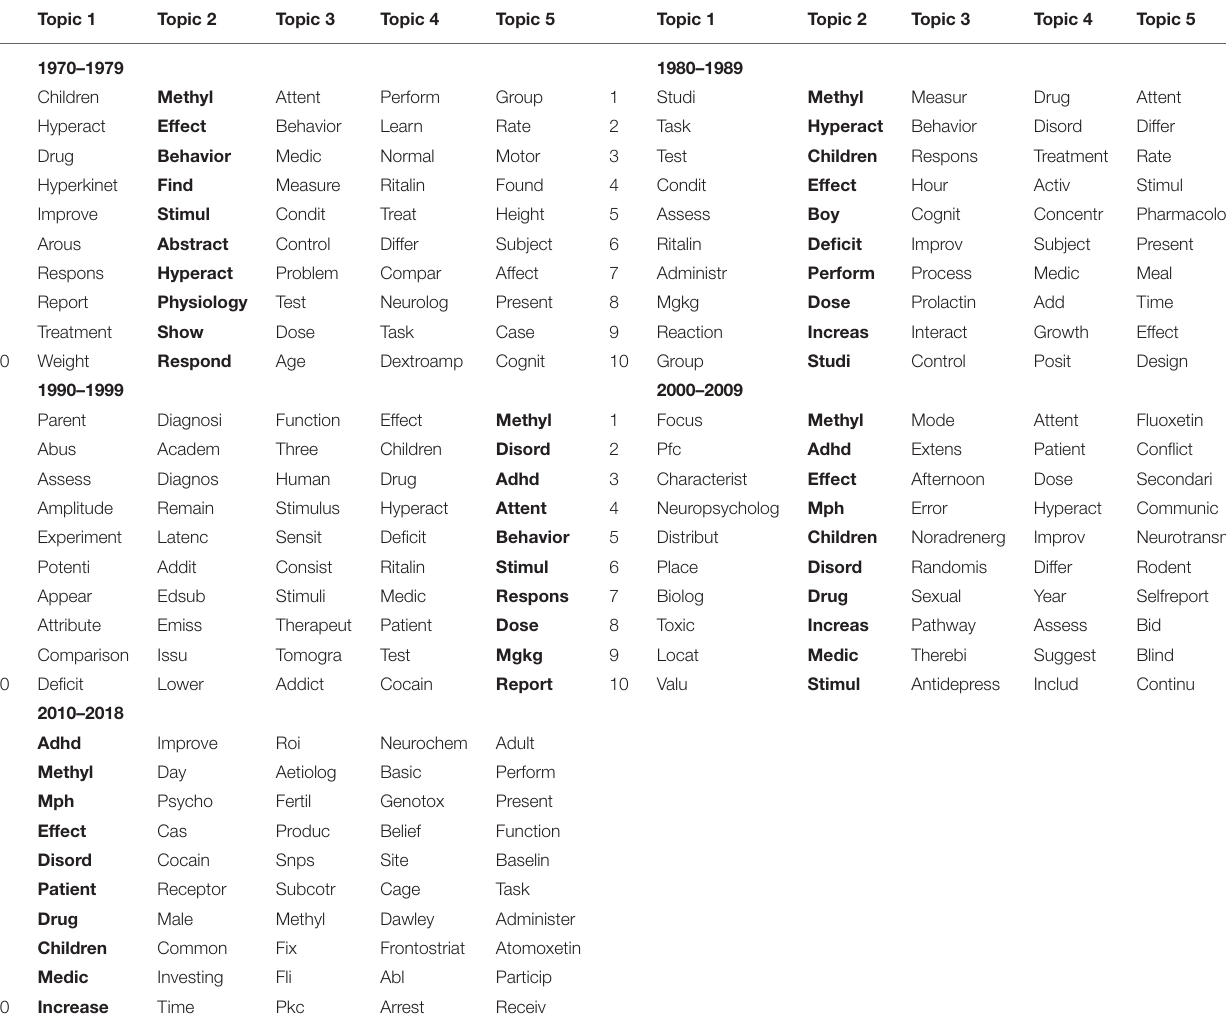
TABLE 1 | ADHD Pharmacotherapy topic models,